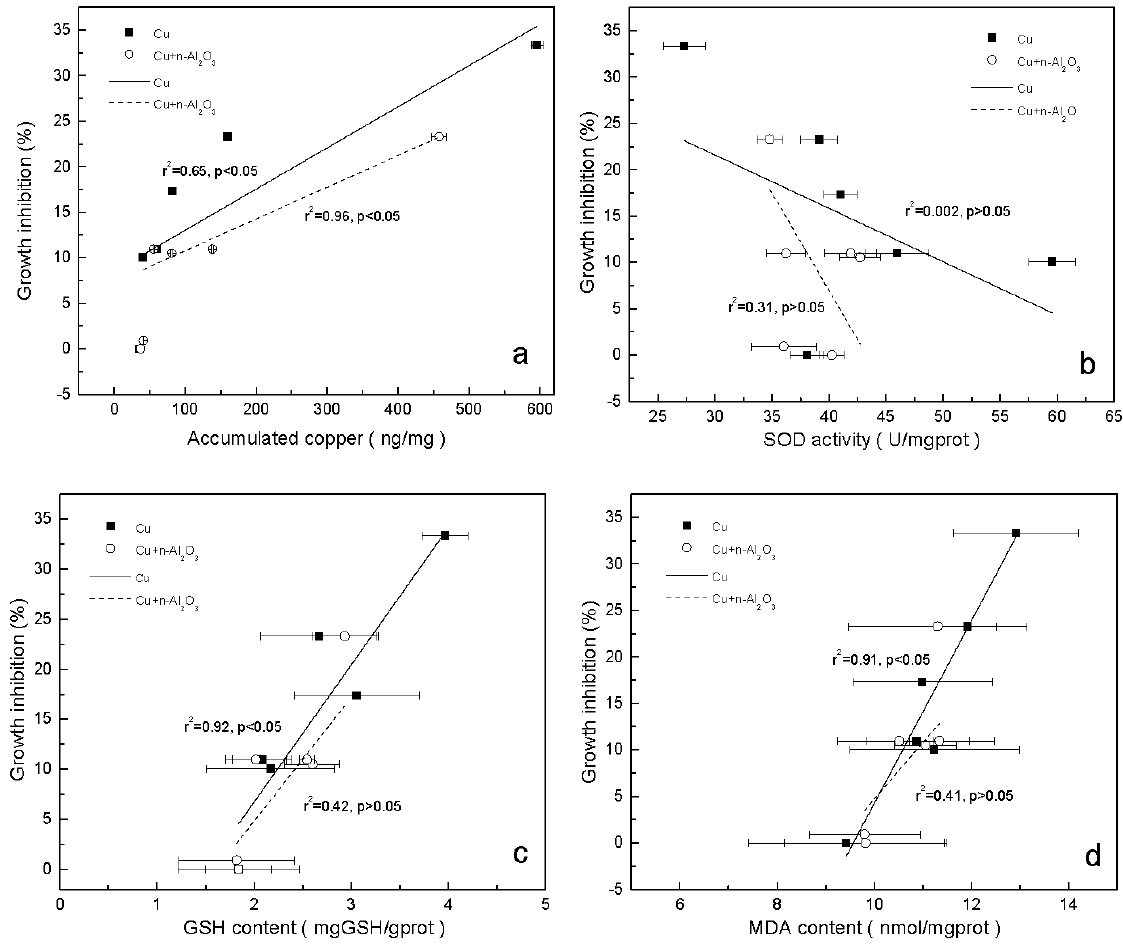
Figure 6. Correlation between growth inhibition and ( a ) accumulated Cu; ( b ) SOD activity; ( c ) GSH concentration and ( d ) MDA concentration (mean ± SD) in S. obliquus exposed to copper and copper/nano-Al 2 O 3 systems at different concentrations of copper after 72 h.